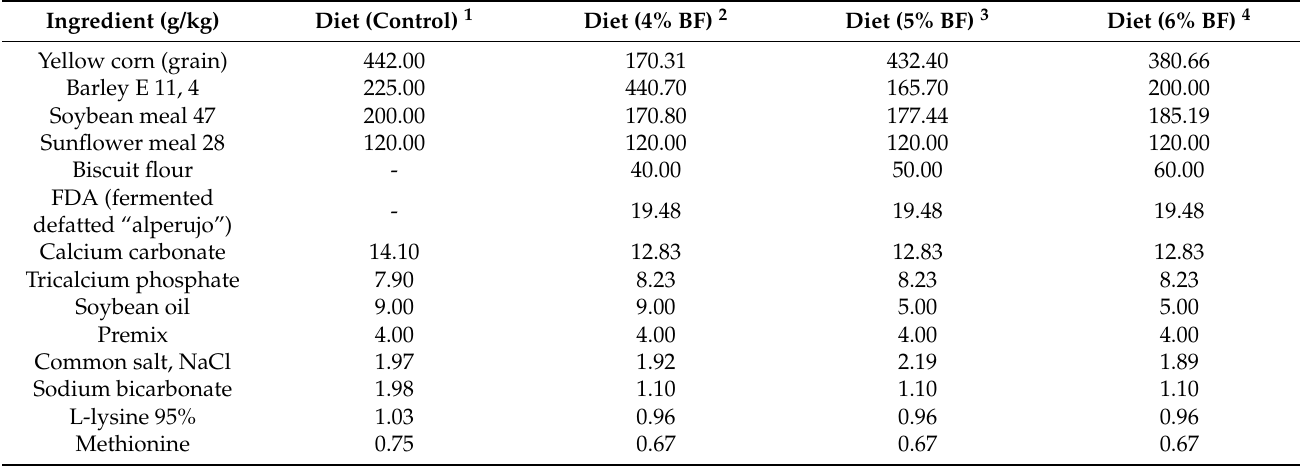
Table 3. Ingredient composition of the control and the supplemented groups: 4%, 5% or 6% biscuit flour (BF) inclusion.